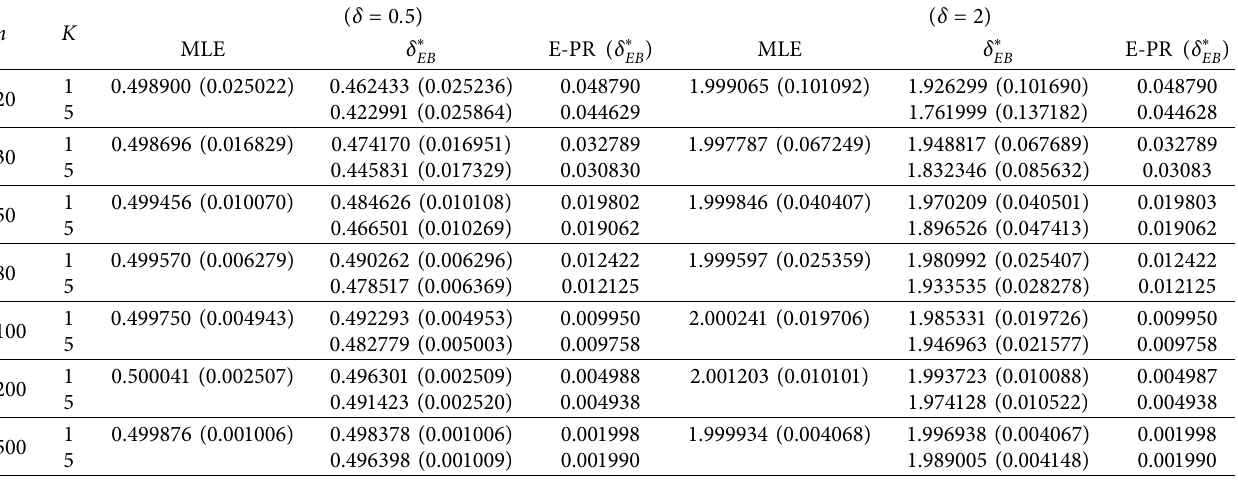
Table 9: E-B and E-PR estimates of